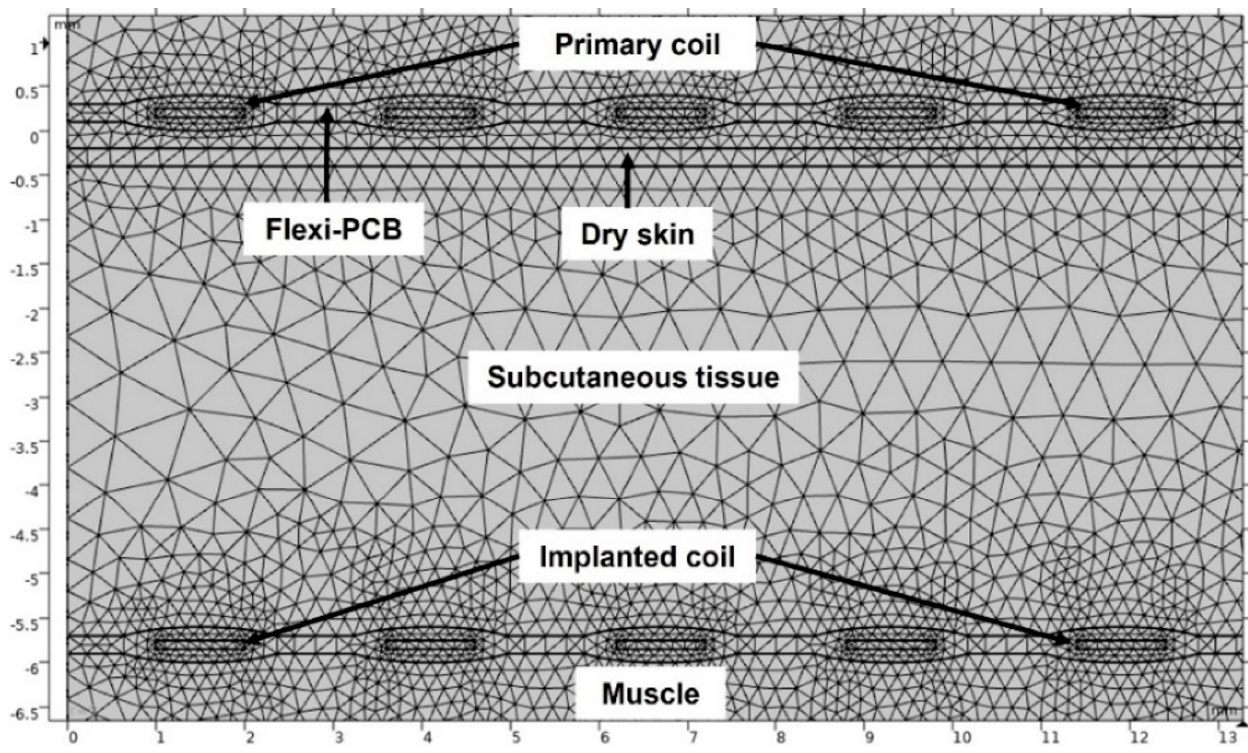
Figure 6. The geometry after applying the meshes. Table 4. Parameters used for the in silico model setup.